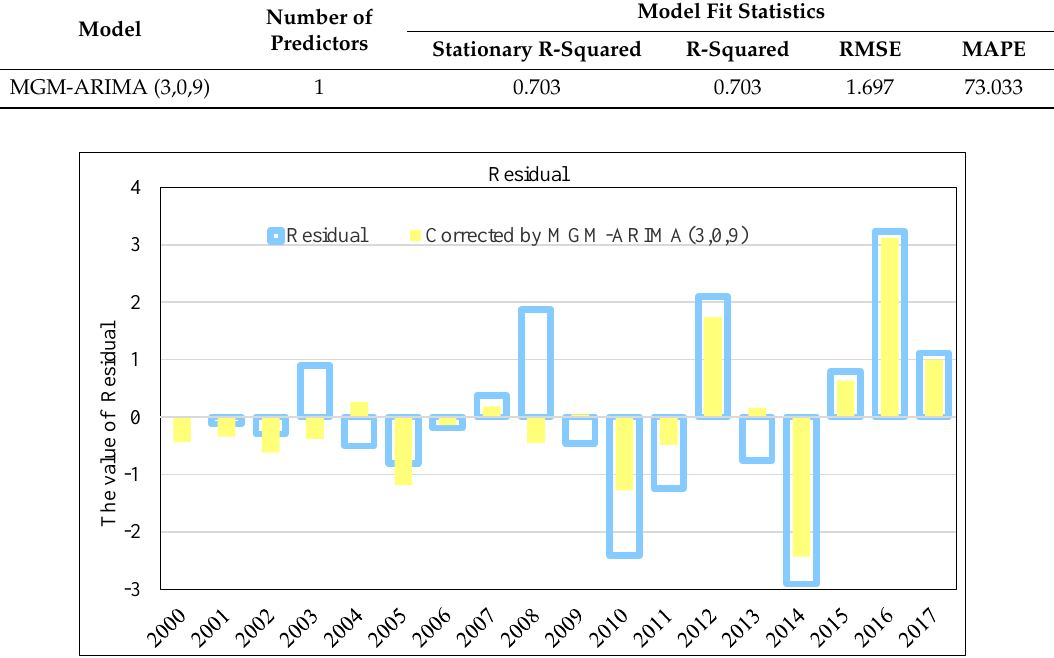
Table 9. Parameters of the goodness of fit for the MGM-ARIMA (3,0,9).